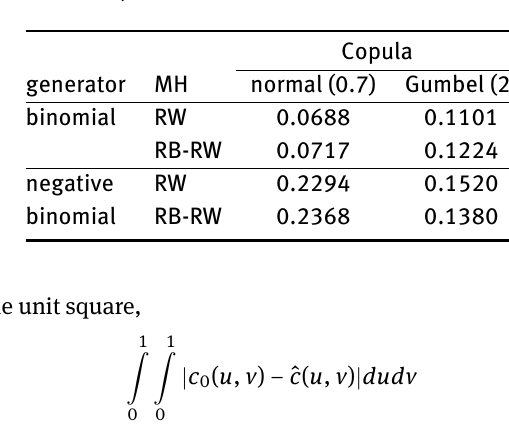
Figure 1: Histogram of the marginal posterior distribution of β (top left), trace plot of the thinned process of β (top right), trace plot of the thinned process of D 11 (bottom left), trace plot of the thinned process of D 1,20 (bottom right). Table 1: Simulated distance of nonparametrically estimated GPUC from parametric copulas. The distance is measured by the integrated absolute difference between the